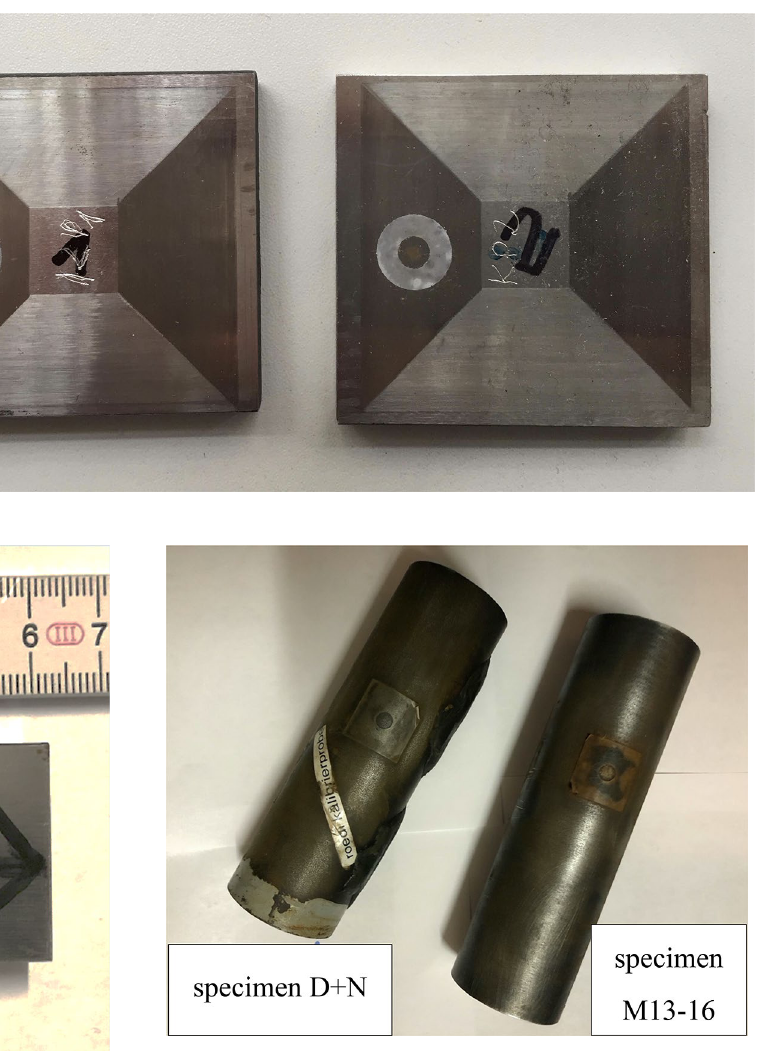
Fig. 3 Shot peened specimen D + N and M13-16. The measuring direction was along the